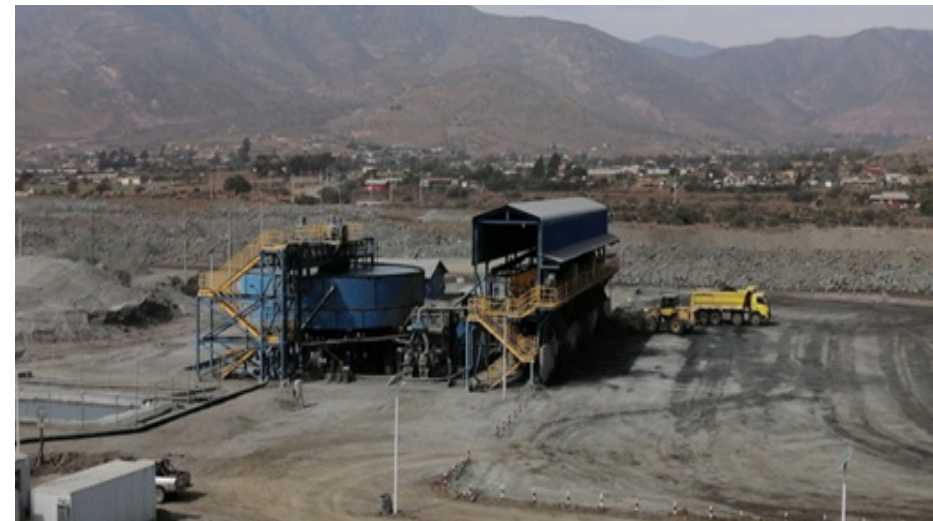
Figure 45. Tambillos Tailings Thickening and Filtering Plant [48,66].